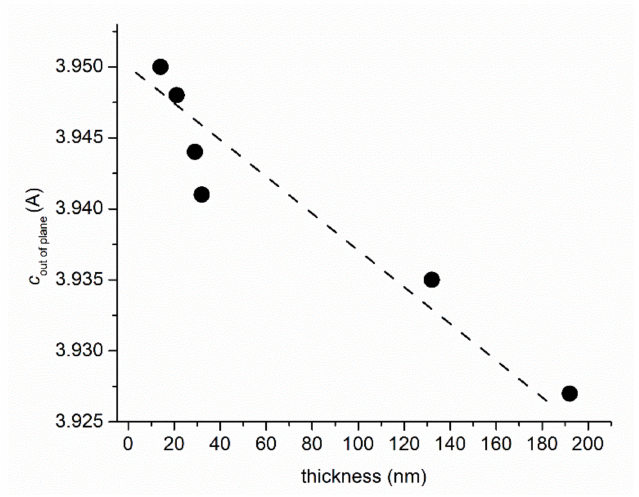
Figure 2. Variation of the thickness of the LFO films (determined via spectroscopic ellipsometry) with the out-of-plane lattice parameter (determined by